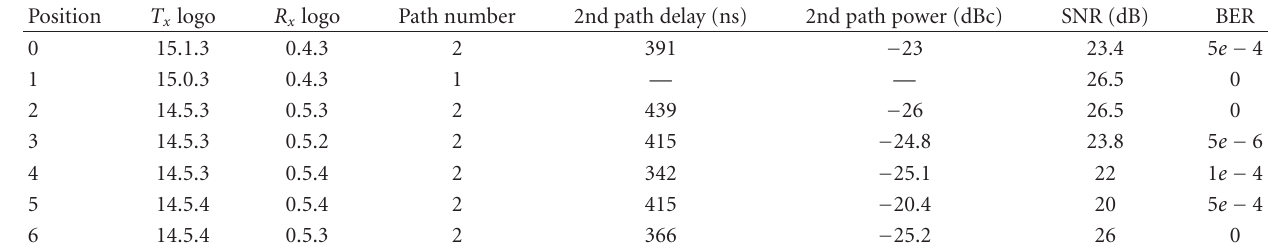
Table 4: SNR/BER for di ff erent locations.